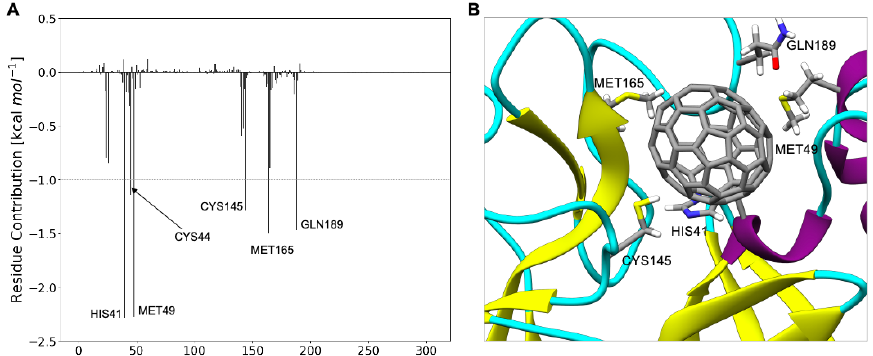
Figure 7. ( A ) C 70 @M pro interactions. ∆ G binding decomposed per residue. ( B ) Interaction between His41, Cys44, Met49, Cys145, Met165, and Gln189 and C 70 .